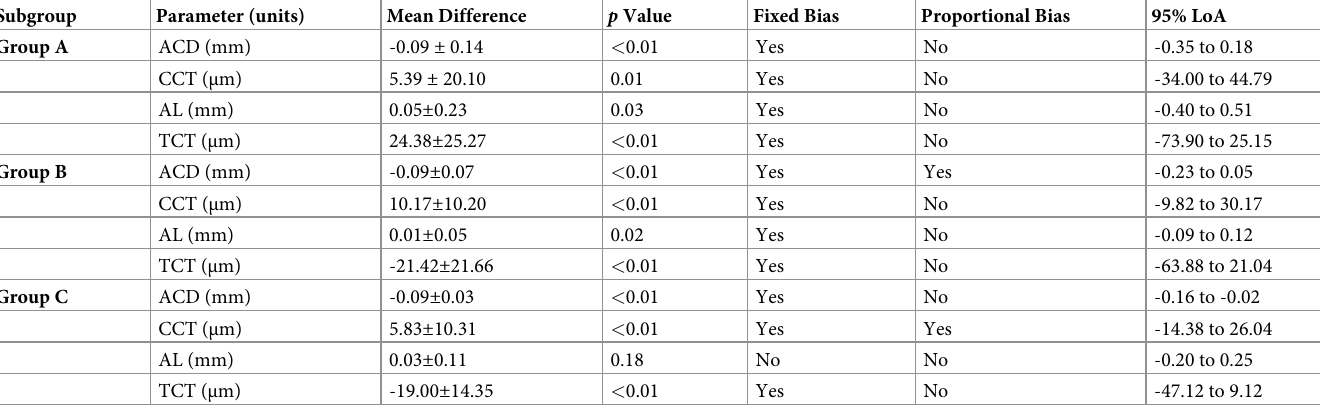
Table 3. Agreement between REVO-NX and Pentacam-AXL in biometric measurements.